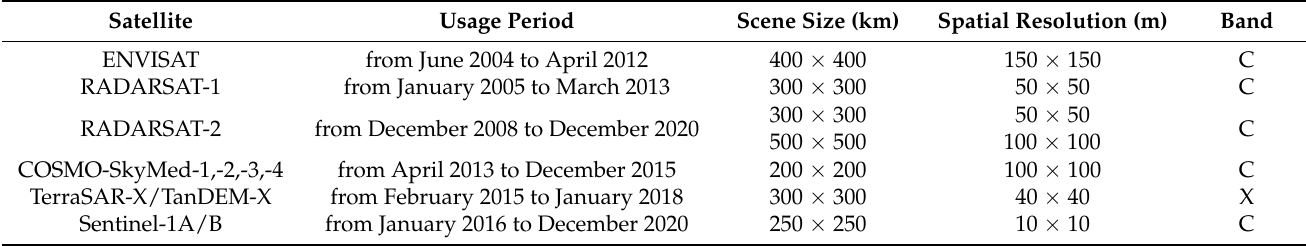
Table 2. Main characteristics of SAR images